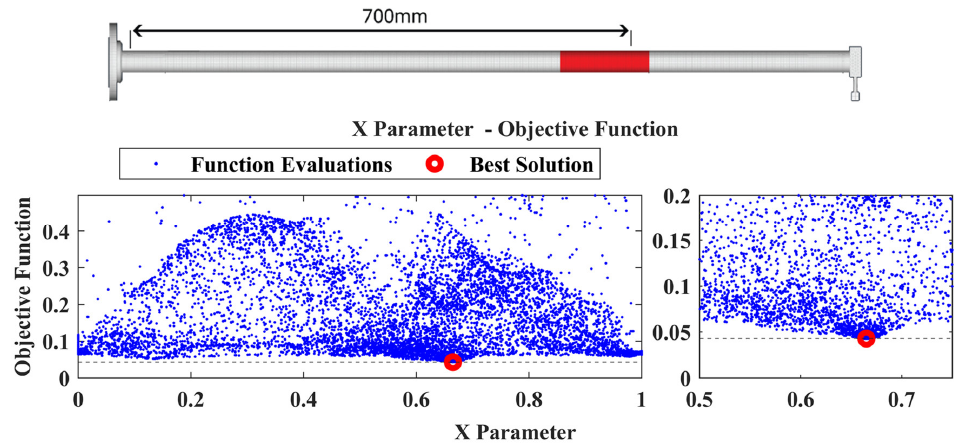
Figure 22. Damaged FE Model along with the location parameter X versus the Objective Function value of Case 2.